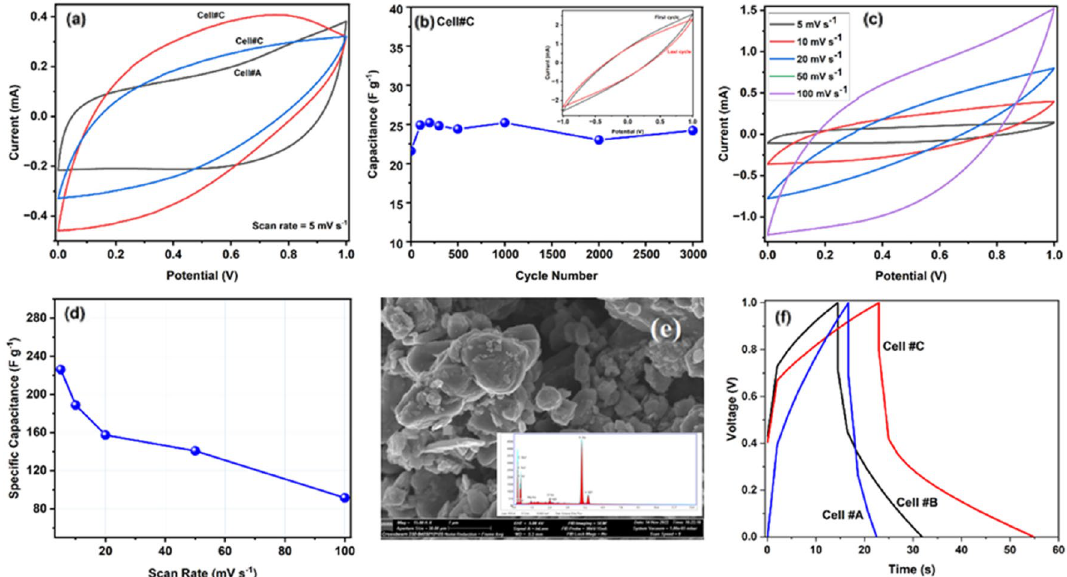
Figure 7. ( a ) Comparative CV curves of the capacitor cells (Cell#A–Cell#C) at a scan rate of 5 mV s −1 , ( b ) Variation of specific capacitance of Cell#C as a function of cyclic voltammetric cycles at a scan rate of 150 mV s −1 . The inset shows the first and last CV curves of Cell#C, ( c ) CV curves of Cell #C at different scan rates, ( d ) Variation of specific capacitance of Cell#C with respect to scan rate, ( e ) SEM–EDX spectra of VO@3 electrode after cycling ( f ) GCD curves of Cell#A-Cell #C recorded at a density of 0.56 A g −1 at room